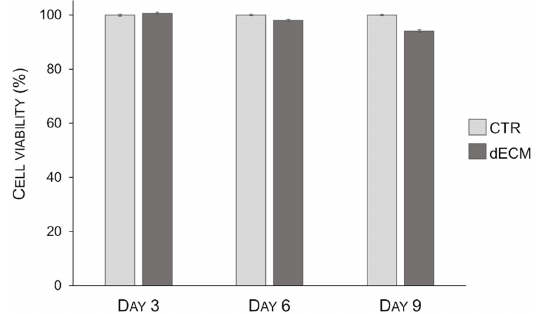
Figure 3. Effect of dECM coating on C2C12 viability. The cells were differentiated on plates either uncoated or coated with dECM up to 9 days and viability was measured by MTT assay. Cell